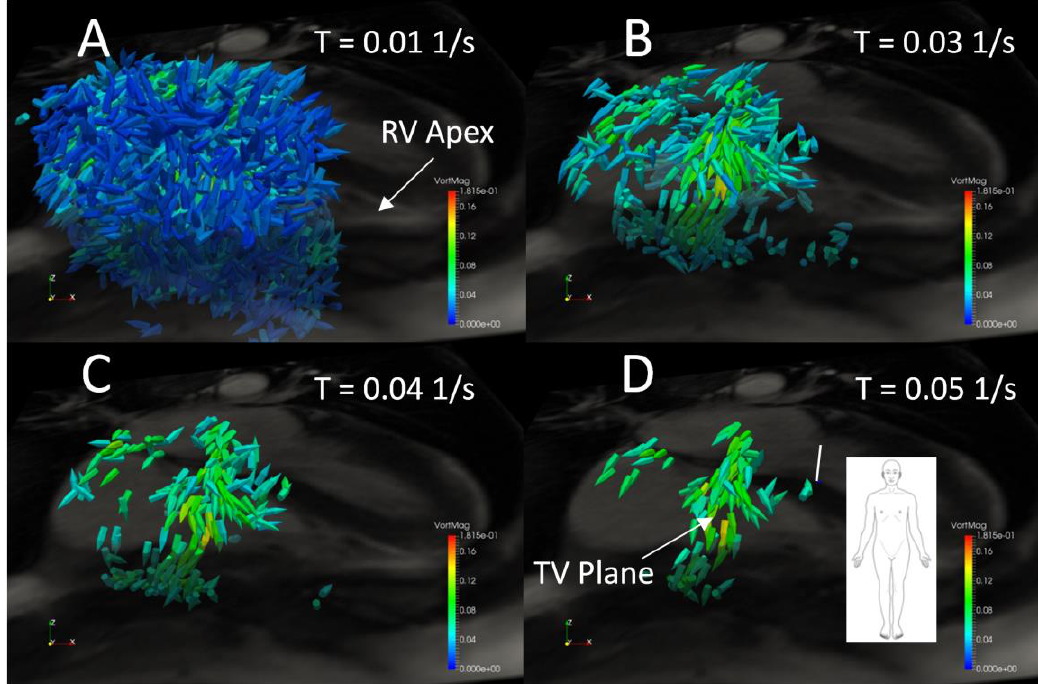
Figure 10. Right heart vorticity during peak early diastole for a normal subject thresholded at ( A ) 0.01 s − 1 , ( B ) 0.03 s − 1 , ( C ) 0.04 s − 1 , and ( D ) 0.05 s − 1 . Vector glyphs are colored by vorticity magnitude and a grayscale 4-Chamber cine image plane is shown for spatial reference.